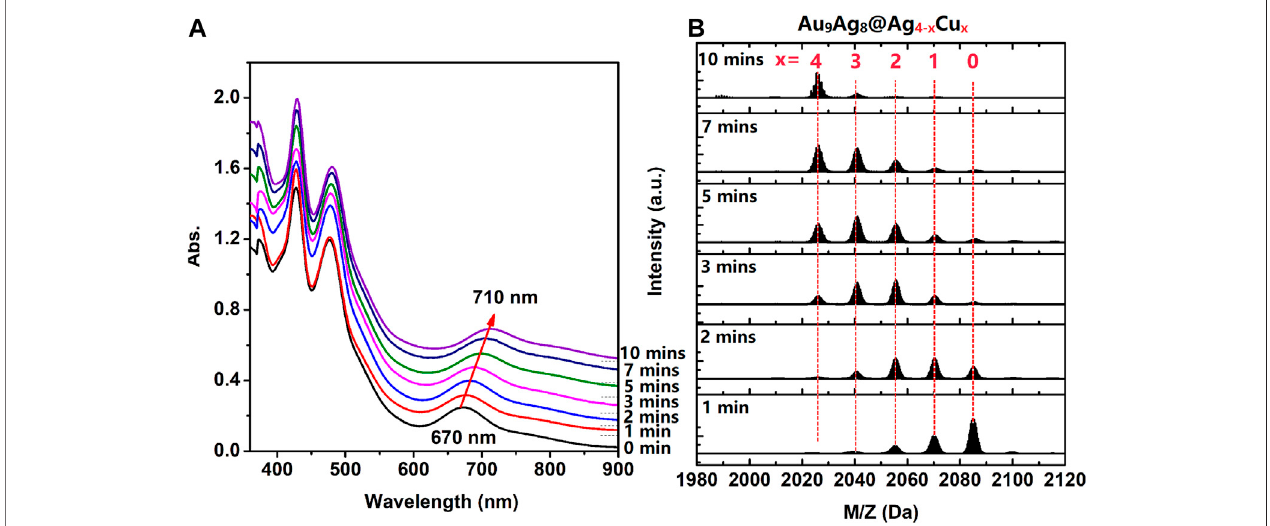
FIGURE 2 | (A) the time-dependent UV-Vis spectra and (B) ESI mass spectra of [Au 9 Ag 12 (SAdm) 4 (Dppm) 6 Cl 6 ](SbF 6 ) 3 in CH 2 Cl 2 after adding Cu I (SAdm) complex precursor.